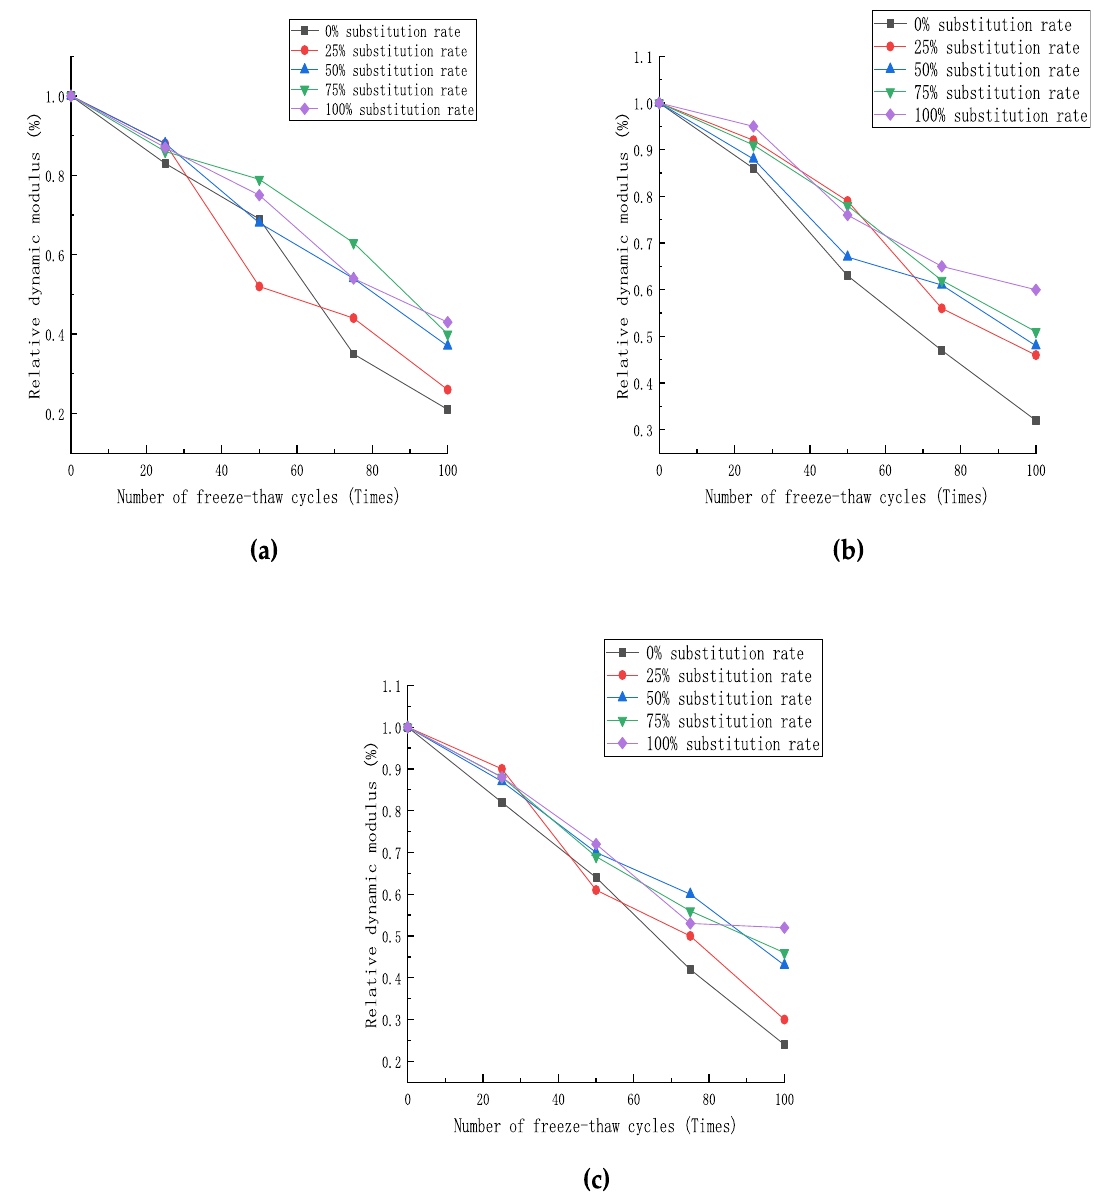
Figure 10. Relative dynamic modulus of specimens: ( a ) steel fiber content 0%; ( b ) steel fiber content 1%; ( c ) steel fiber content